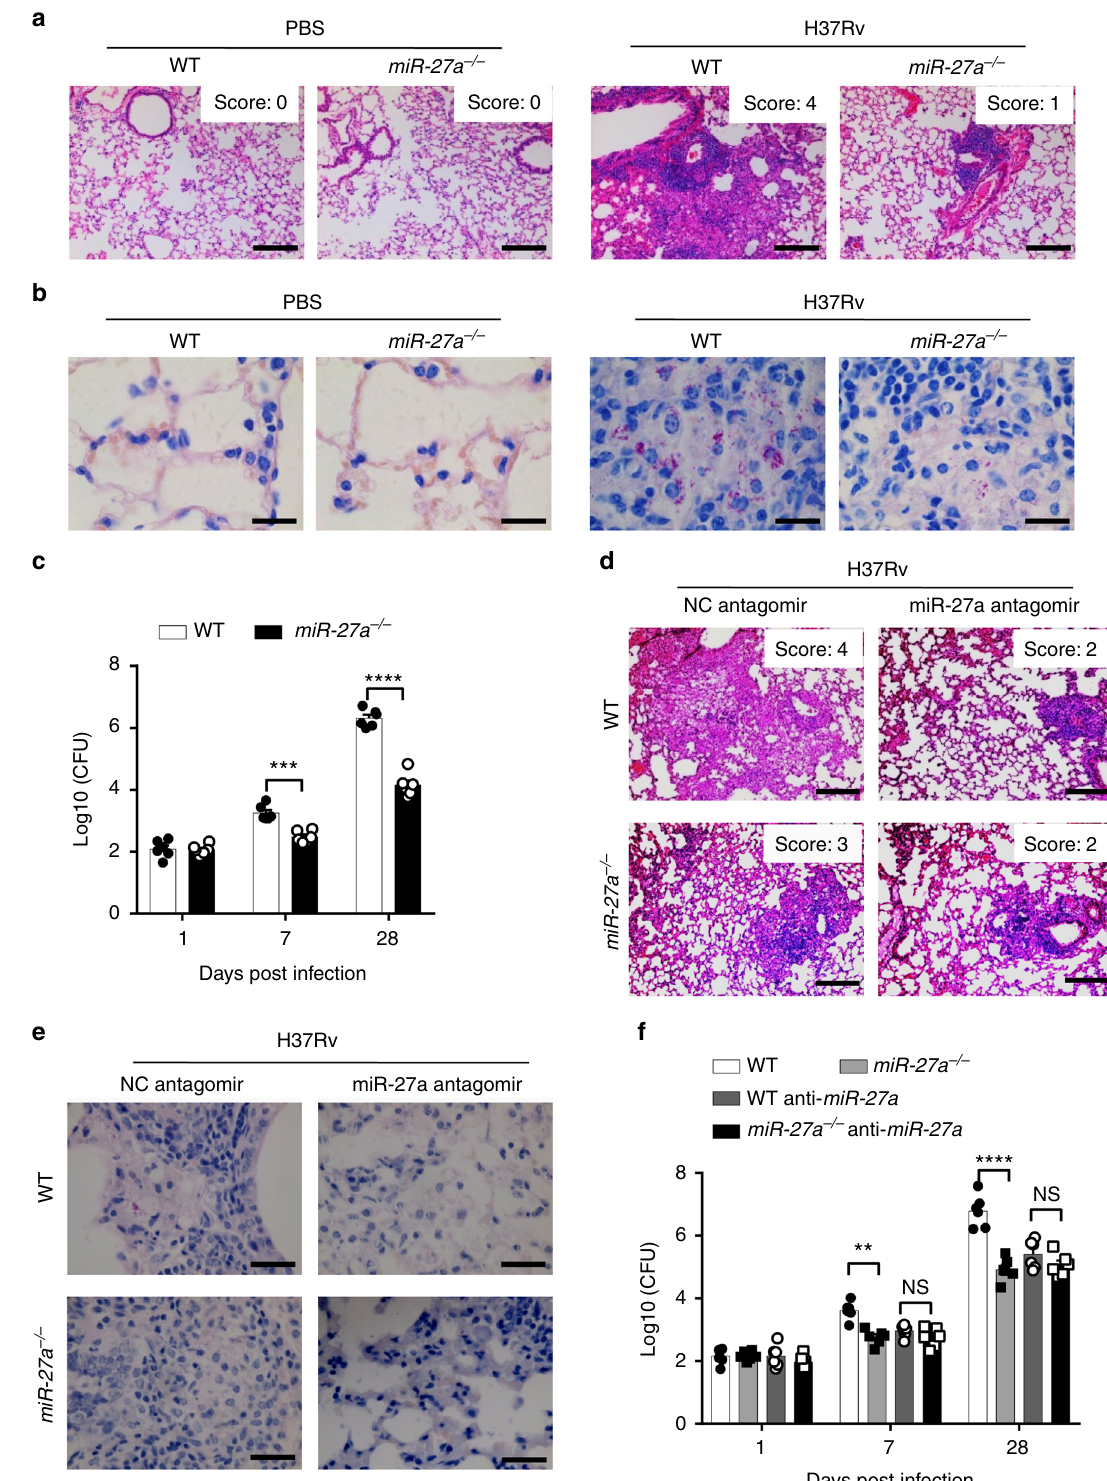
Fig. 2 miR-27a controls susceptibility to Mtb . a – c WT or miR-27a -/- mice were infected with Mtb H37Rv for 28 days, and the lungs were subjected to ( a ) H&E staining. Scale bar, 100 μ m; ( b ) acid-fast staining of bacteria. Scale bar, 20 μ m. ( c ) CFU assay. d – f Mice were infected with Mtb for 28 days,